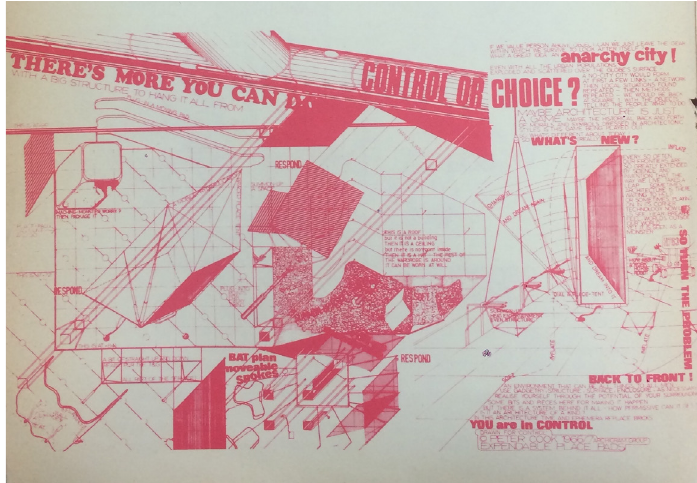
Archigram, “Control and Choice”, in Marcatrè 52/55 (1969),